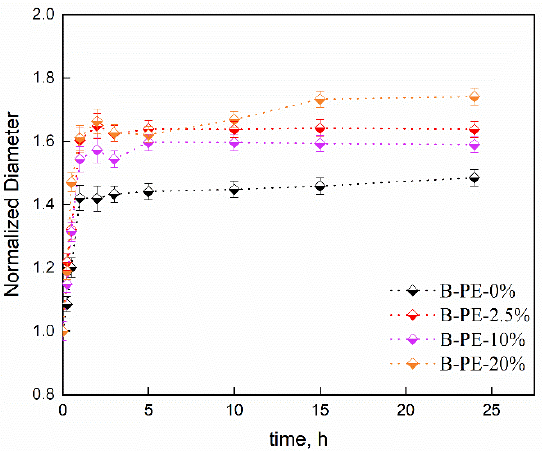
Figure 5. Normalized diameter trends over time as a function of PE content.